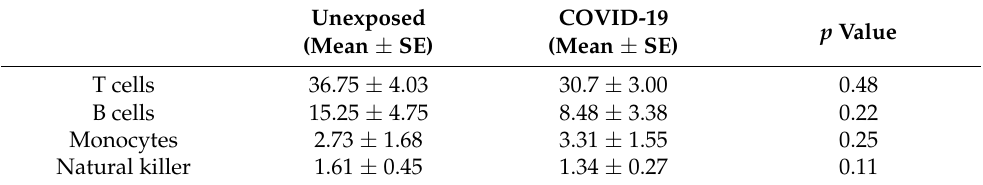
Table 3. Absolute frequency of circulating peripheral blood mononuclear cells from the study population. Unexposed (Mean ±